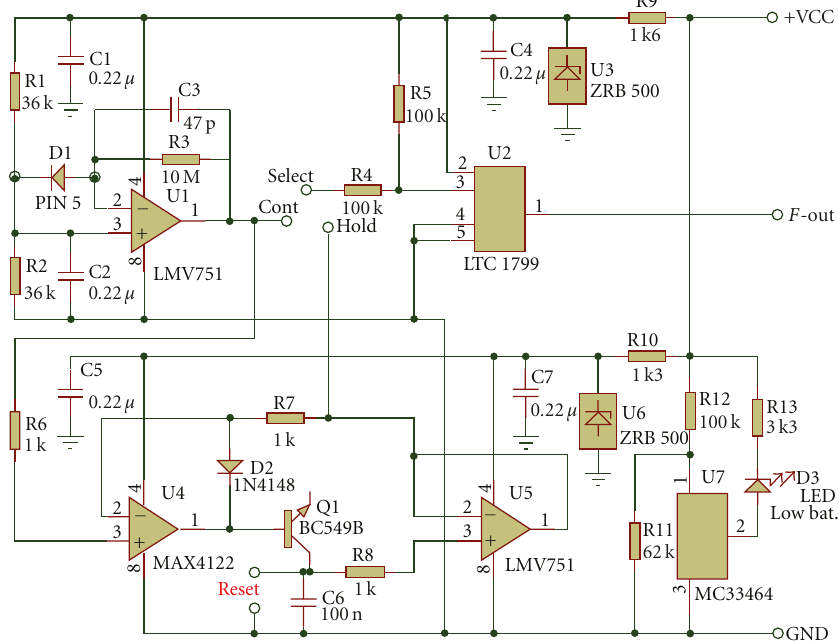
Figure 2: Schematic diagram of a prototype instrument used for scintillation